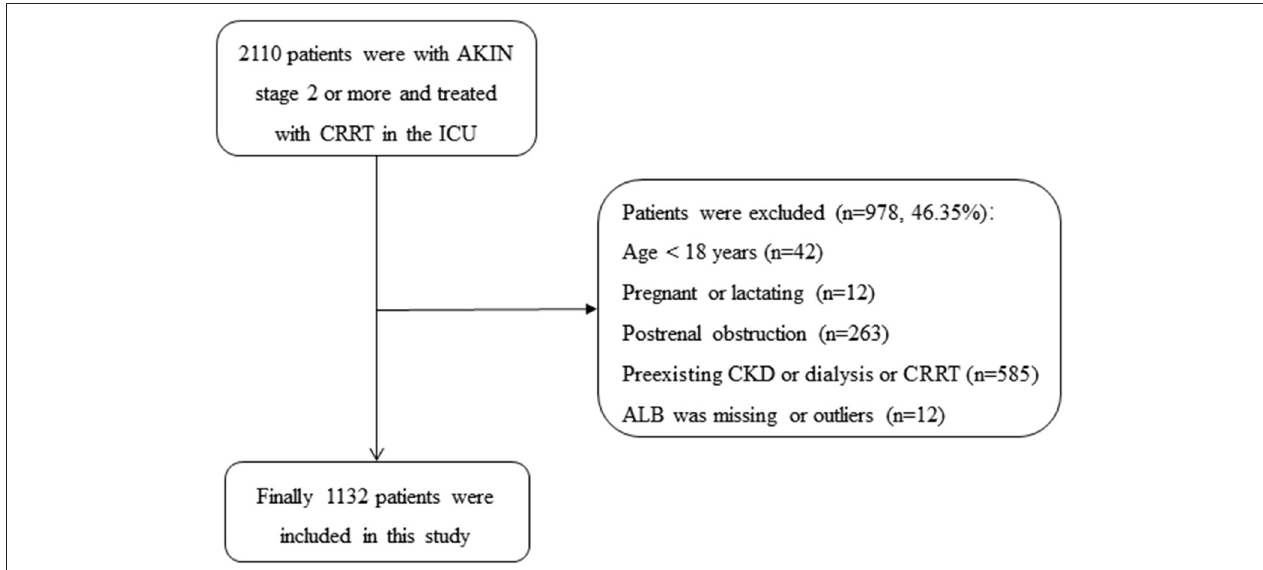
FIGURE 1 | Flowchart of patient selection. AKIN, acute kidney injury network; ALB, albumin; CKD, chronic kidney diseases; CRRT, continuous renal replacement therapy; ICU, intensive care unit.